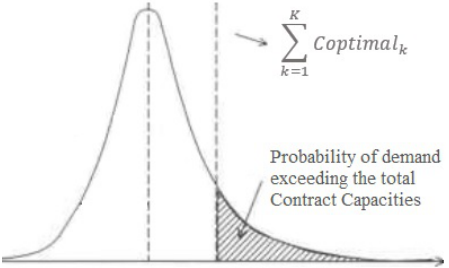
Figure 1. Illustration of probability excess demand (own